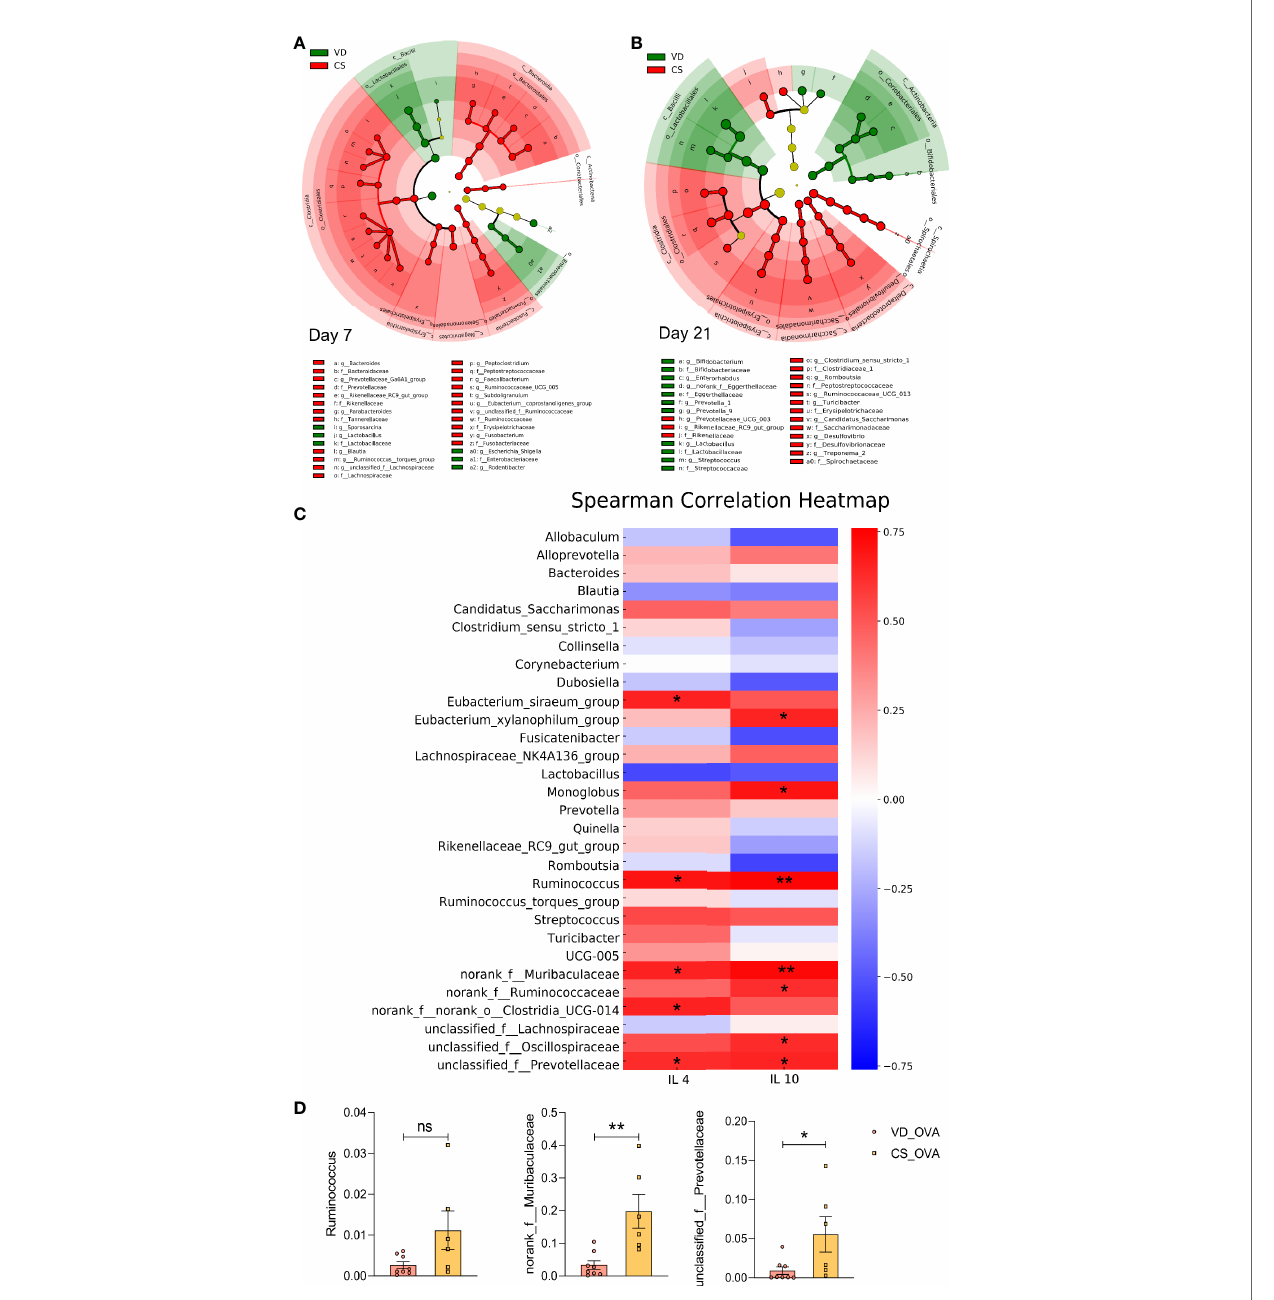
FIGURE 4 | Food allergy is linked to the differences in microbiota induced by CS. (A, B) Cladogram based on LEfSe analysis from phylum to genus level with the value of the Kruskal – Wallis rank-sum test set to 0.05 on Days 7 (A) and 21 (B) . (A) Day 7 (VD n = 6, CS n =7). (B) Day 21 (VD n = 9, CS n =9). (C) Spearman Correlation heatmap indicated the correlation between the protein levels of IL-4 and IL-10 and abundance of genera (n = 6). Positive and negative correlations are shown in red and blue blocks, respectively. Spearman ’ s correlation coef fi cients >0.75/< − 0.75. (D) The relative abundance of some speci fi c microbes that are positively correlated with the levels of IL-4 and IL-10 in (C) on Day 70 (VD_OVA n = 8, CS_OVA n = 6). * P < 0.05, ** P < 0.01; ns, no signi fi cance; VD, vaginal delivery; CS, cesarean